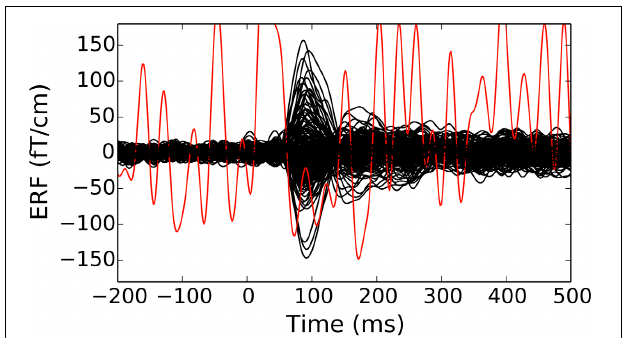
FIGURE 4 | Source localization of an auditory N100 component. Left: Results obtained using dSPM and a surface source space based on combined MEG and EEG data. The figure was generated using the plot method of the SourceEstimate class which internally calls PySurfer . Right: Results obtained using LCMV beamformer and a volume source space based on MEG channels only. The figure was generated using Freeview shipped with